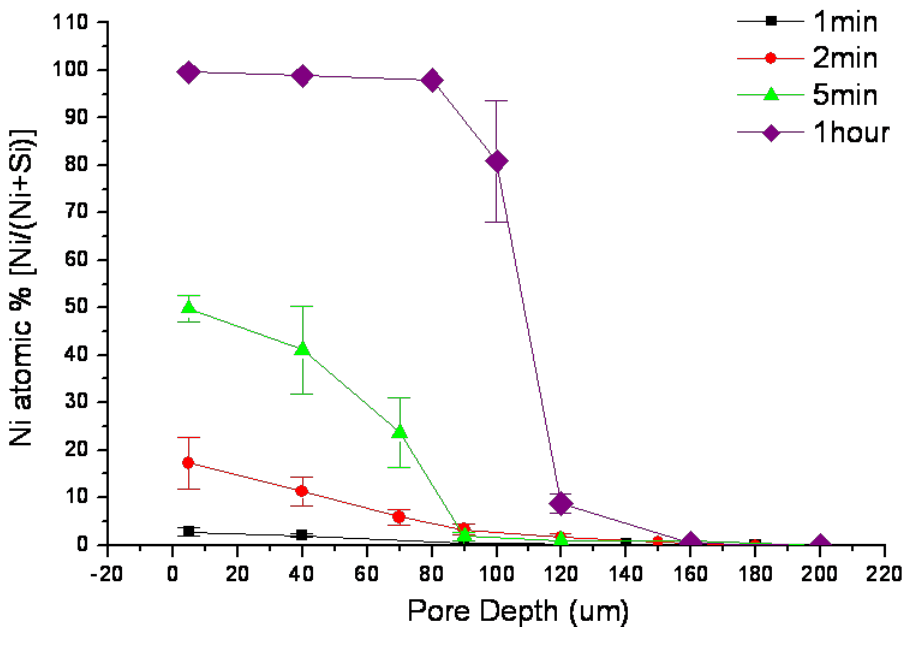
Figure 2. Plots of Ni atomic percentage profile measured by EDX along the pore depth for different immersion times: 1 minute, 2 minutes, 5 minutes and 1 hour.